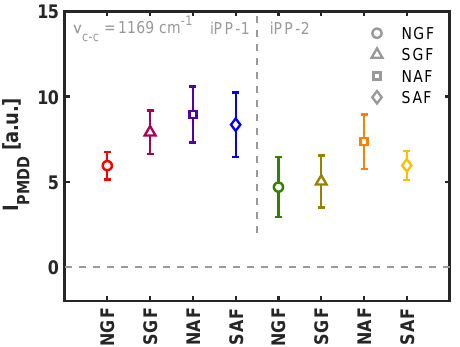
Figure 9. Differential dichroic intensity of the vibrational band corresponding to backbone stretching for various combinations of the two homopolymer materials and fiber types. Analogously to Figure 7, the markers represent the average degree of orientation, while the error bars indicate the positional spread of the